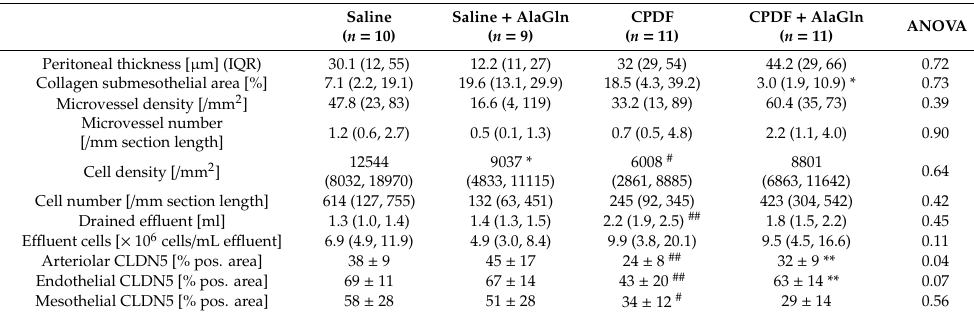
Table 2. Parietal peritoneal tissue morphology and CLDN5 abundance of mice treated with conventional PD fluid (CPDF) and saline. Two-way ANOVA was performed for e ff ect of AlaGln intervention, followed by t-test / Mann-Whitney test for AlaGln e ff ect within the